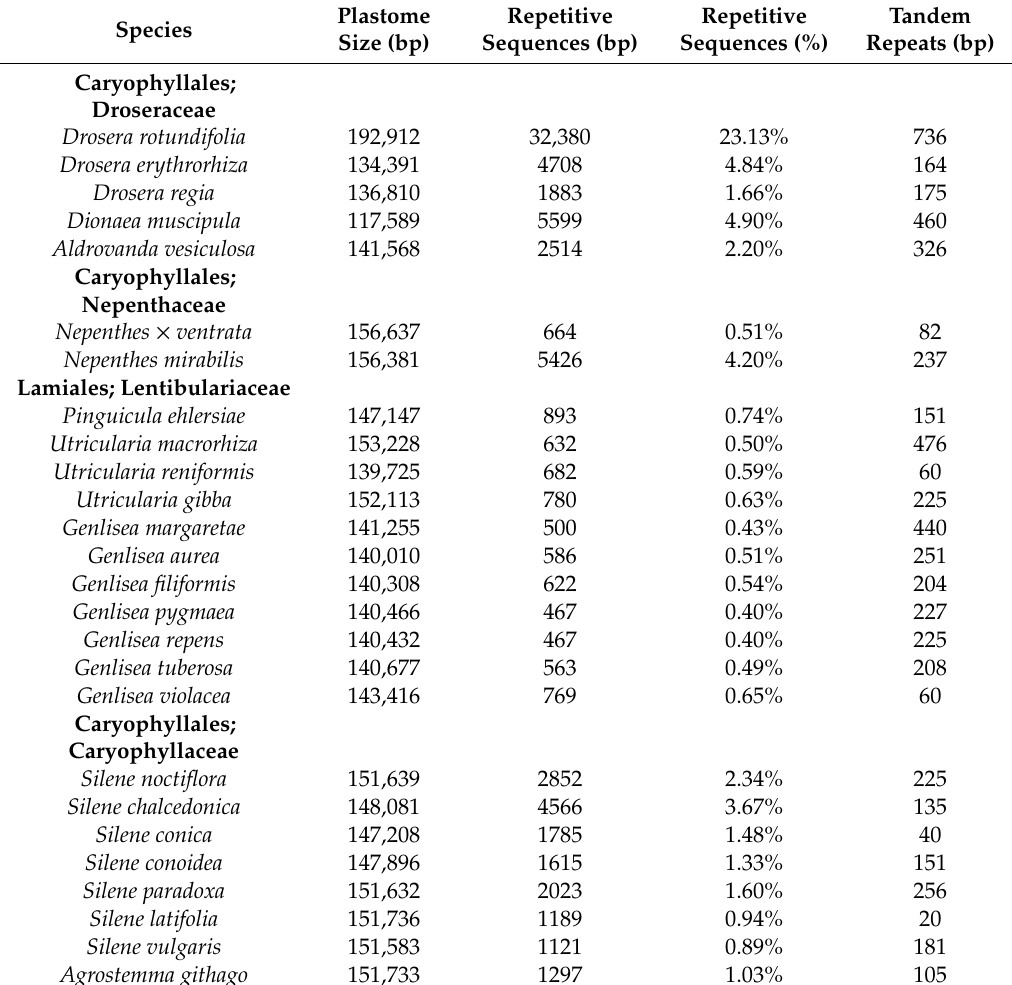
Table 2. Repetitive sequence content in plastid